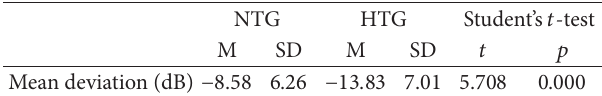
Table 8: Mean deviation at the moment of diagnosis (dB). NTG HTG Student’s 𝑡 -test